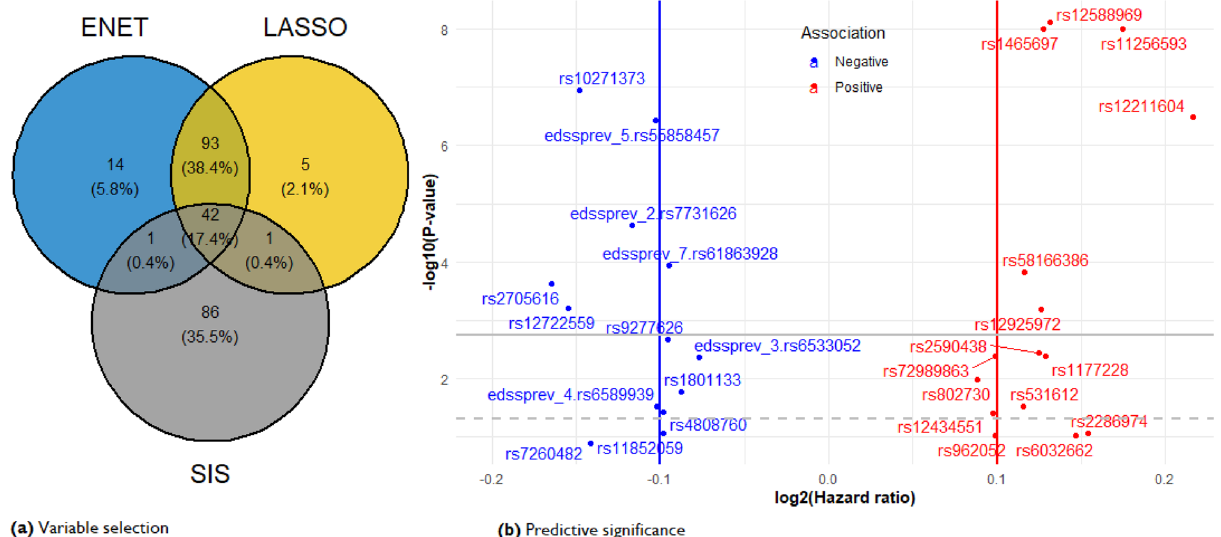
Figure 3. ( a ) Number of genetic variations shared among tenfold CV by variable selection methods. ( b ) Volcano plot significance of SNPs in the multivariate prognostic model. Statistical significance at the multivariate cut-off level is − log10( α = 0.05) = 1.30 (grey dash-lines), family-wise error rate at − log10( α = 0.05/28) = 2.75 (grey solid-lines).